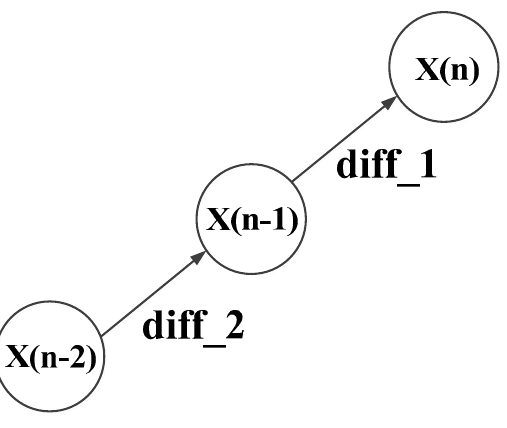
Figure 1. Slope prediction using diff_1 and diff_2 .